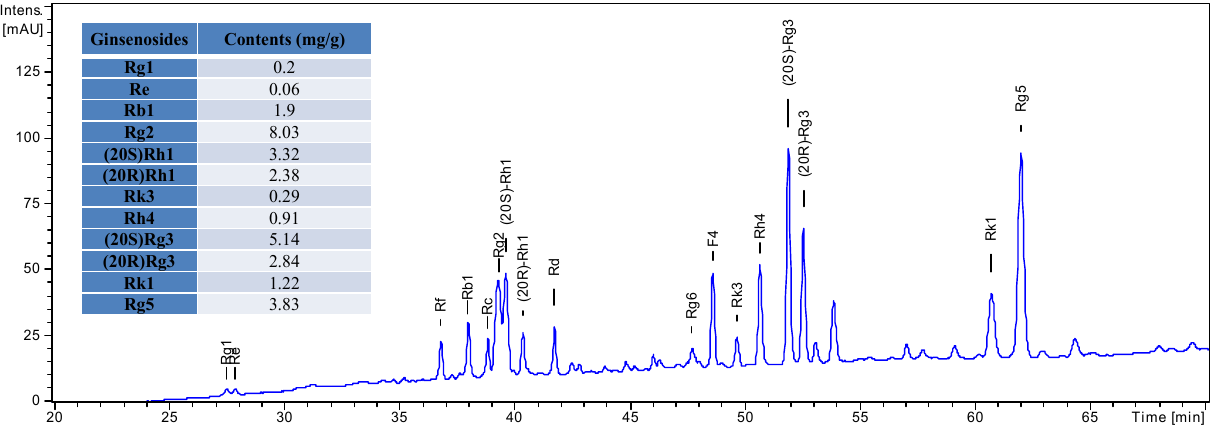
Figure 1. LC-UV chromatograms of the RSE hydrolysates